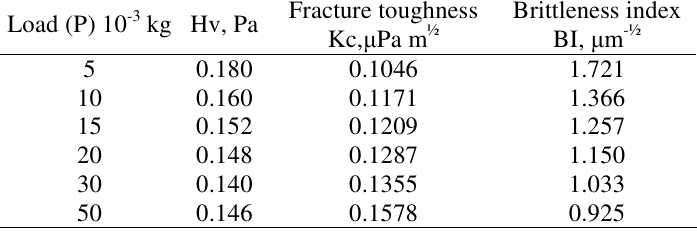
Figure 9. Hardness Number (Hv) vs. Load (P) of ZSHH crystal. Table 2 . Mechanical properties of ZSHH single